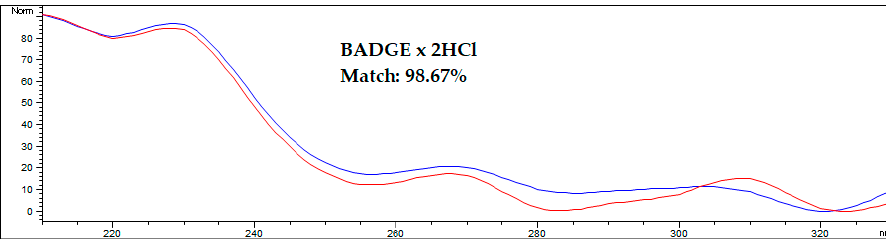
Figure 4. Comparing the spectrum of the BADGE ∙ 2HCl standard with the spectrum acquired during HPLC-FLD analysis of spiked amniotic fluid samples after optimized DLLME procedure. The blue line represents the standard solution in methanol, the red line represents the spiked human amniotic fluid sample. Results were obtained for a sample spiked at 50 ng/mL.